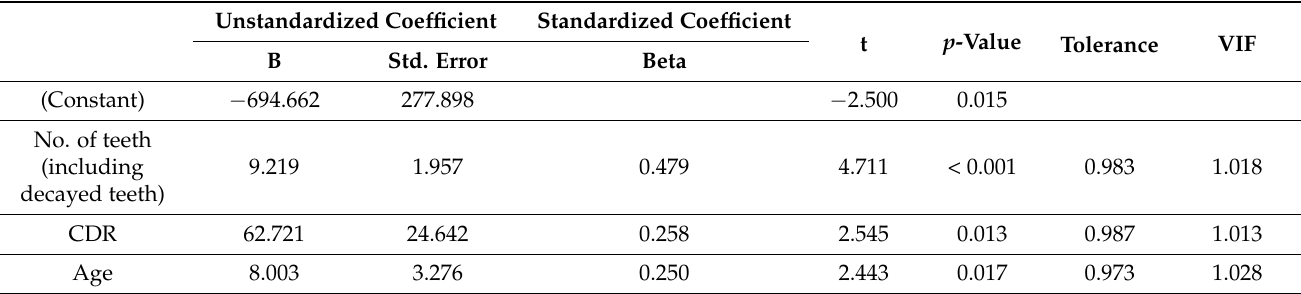
Table 3. Multiple linear regression analysis for PISA: the final multivariate